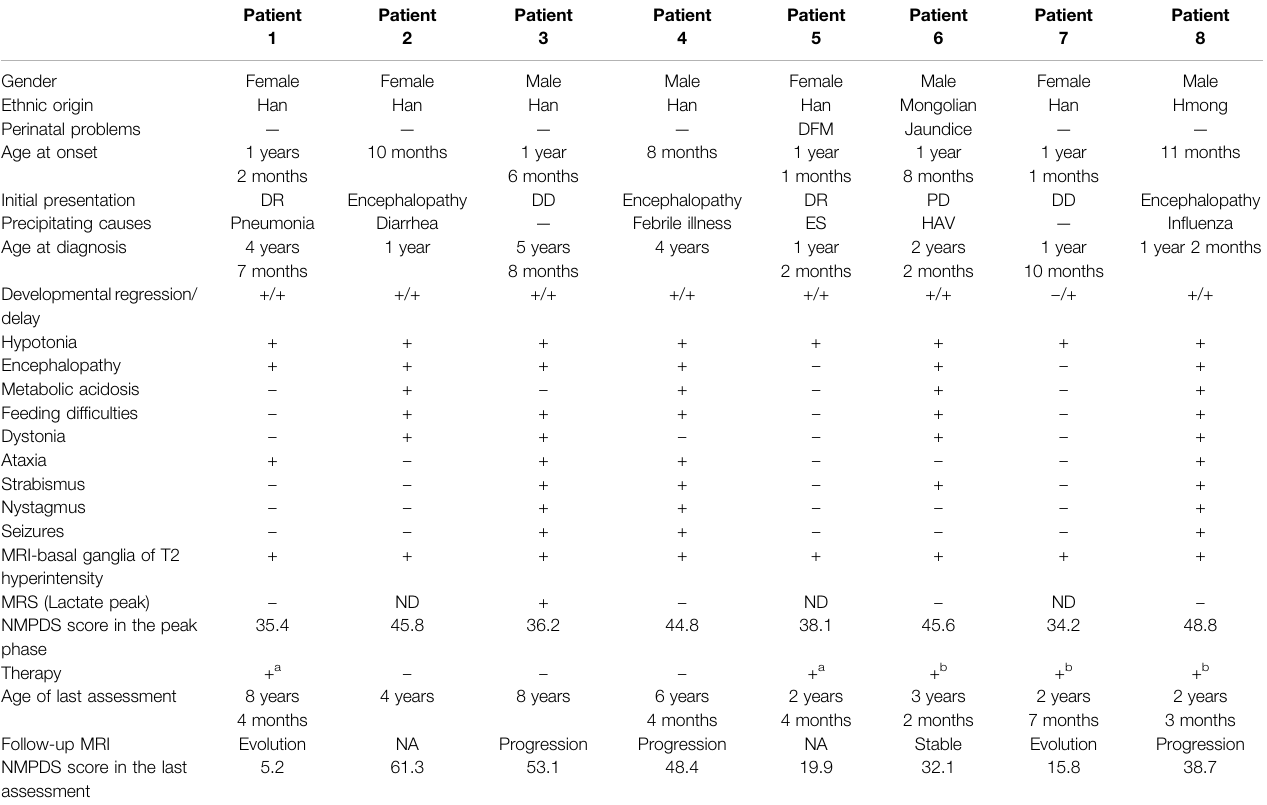
TABLE 3 | Clinical features and follow-ups of eight patients with HIBCH